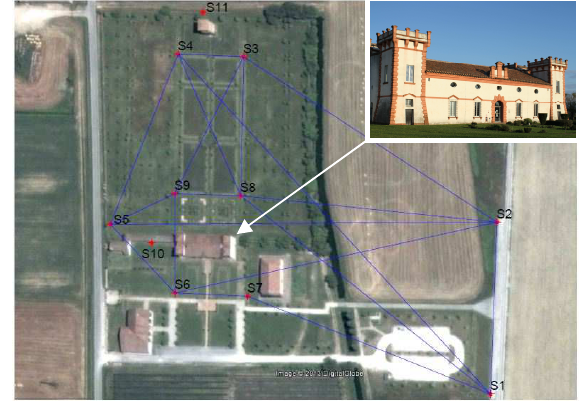
Figure 2. The 3D reference network